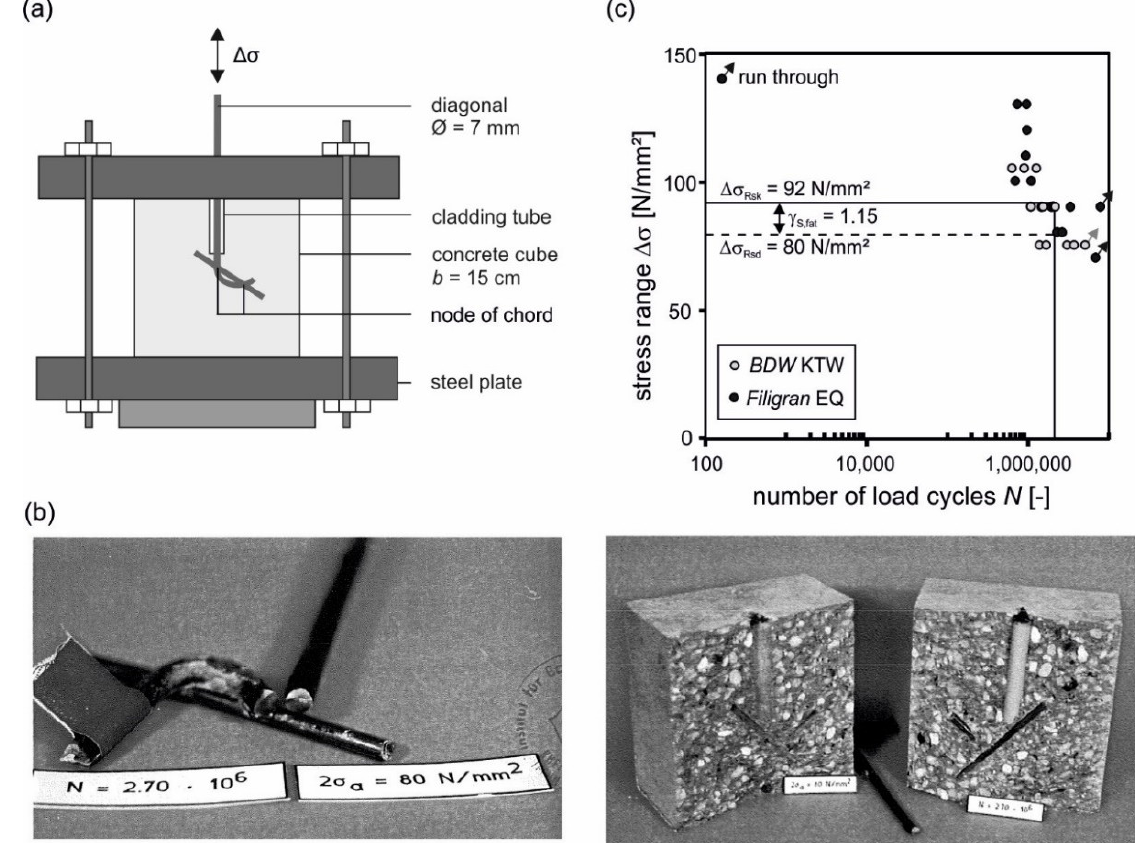
Figure 4. Investigations to determine the stress range resistance according to [40,52]: test setup ( a ), fracture of node ( b ), and test results ( c ).